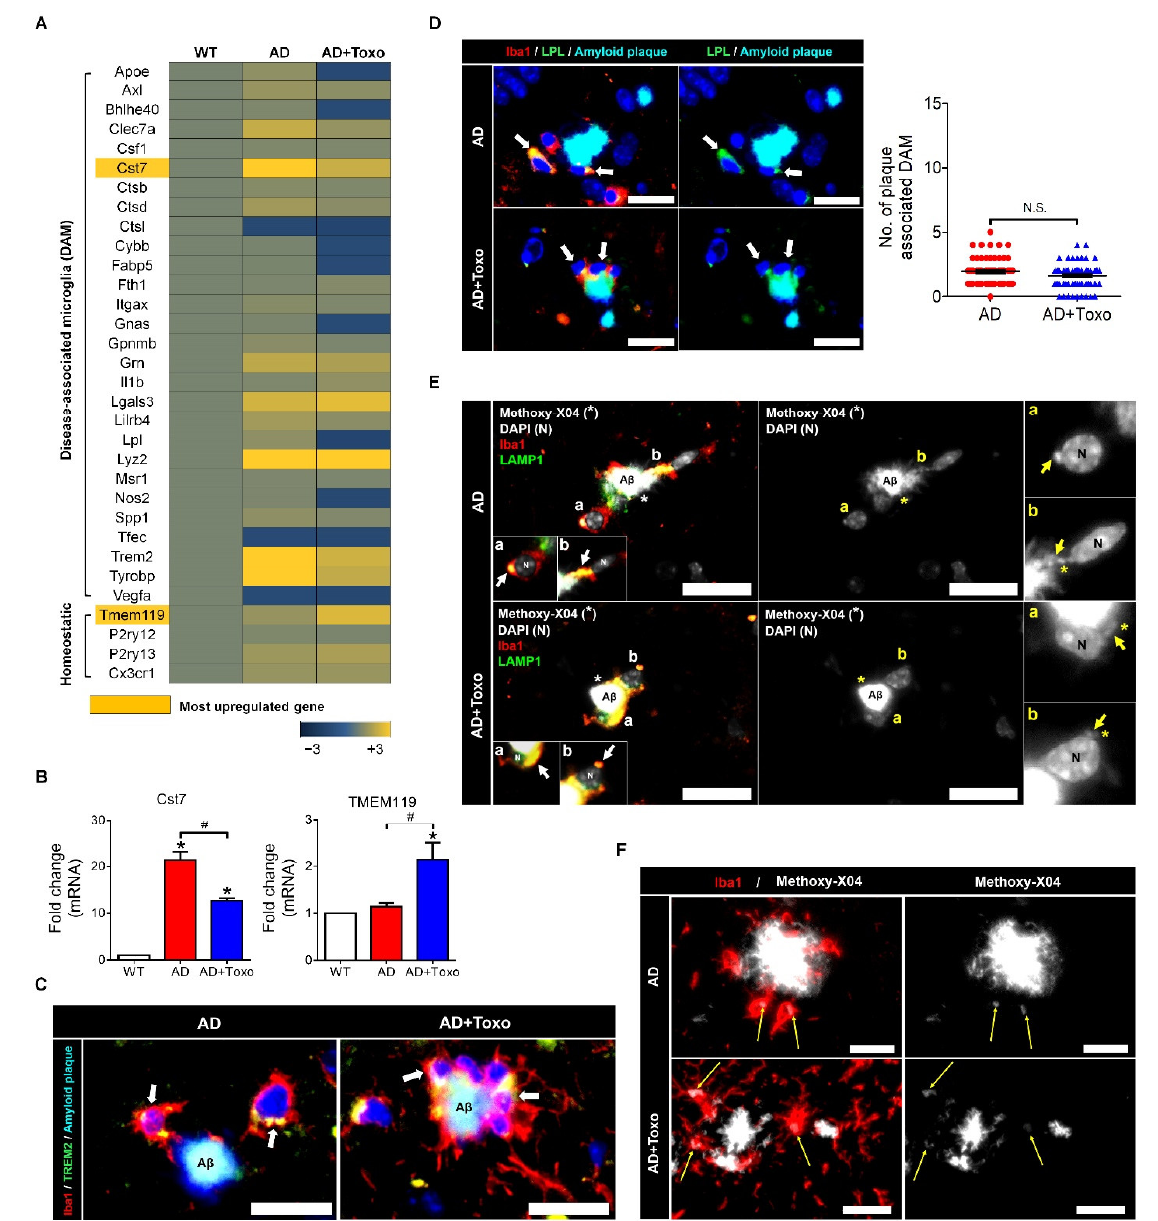
Figure 4. Disease-associated microglia (DAM) phenotype of microglia and microglial phagocytosis. ( A ) DAM- or homeo- static markers of microglia investigated by gene array analysis. ( B ) qPCR results for Cst7 and Tmem119 . ( C ) The TREM2 signal is a predictor of the DAM phenotype. (yellow, due to co-staining of Iba-1 (red) and TREM2 (green) and indicated by an arrow); Scale bar; 20 µm. ( D ) Lipoprotein lipase (LPL) signal as a stage two marker in DAM. The number of plaque- associated and LPL-expressing microglia. The counting result of microglia found around 60 amyloid plaques distributed in the brain ((10 randomly selected plaques per mouse) × 6 mice per group). (yellow, due to co-staining of Iba-1 (red) and LPL (green) and indicated by an arrow); Scale bar; 20 µm. ( E ) LAMP1 expression, and colocalization of LAMP1 and Iba1 in microglia around the amyloid β (Aβ) plaque. Lysosomal degradation of Aβ plaque as seen by the internalized puncta per microglial cell. Both “a” and “b” indicate LAMP1 positive lysosomes (white and yellow arrow) with the colocalization of methoxy-X04 stained amyloid β (*). Scale bar; 20 µm. ( F ) Internalized puncta per microglial cell indicate lysosomal degradation of the Aβ plaque (yellow arrow). Scale bar; 20 µm. Data are represented as the mean ± SEM. * Statistical significance compared with the control (* p < 0.05). # Statistical significance compared with each experimental group ( # p < 0.05).